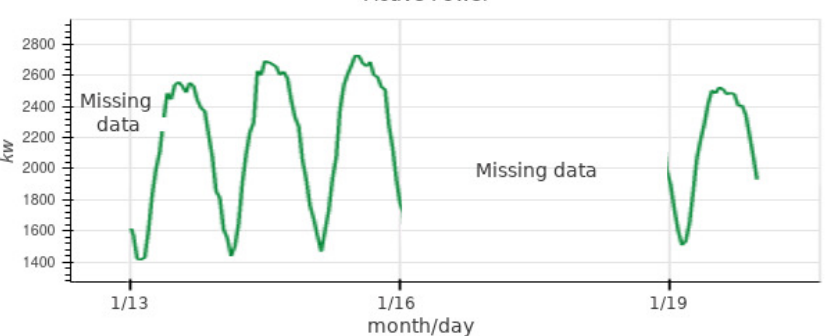
Figure 8. Time series with missing